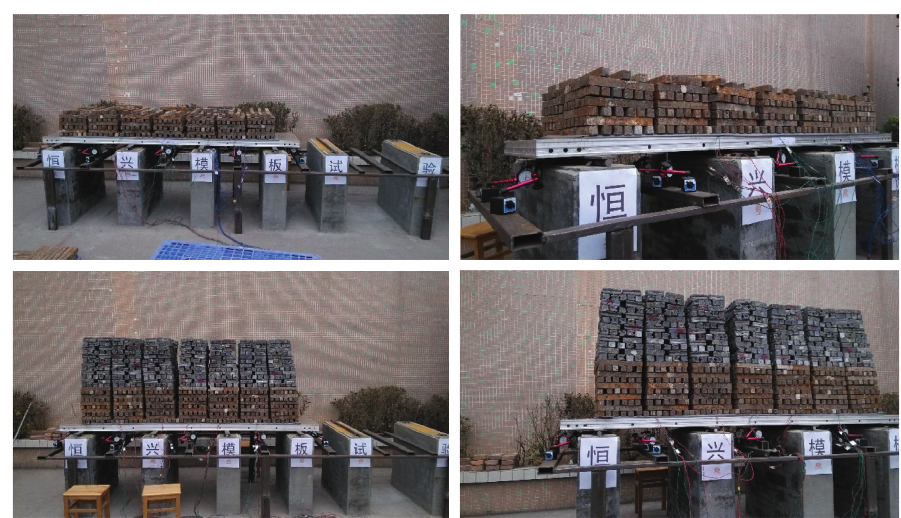
Figure 12: Loading process of the three-span continuous formwork.